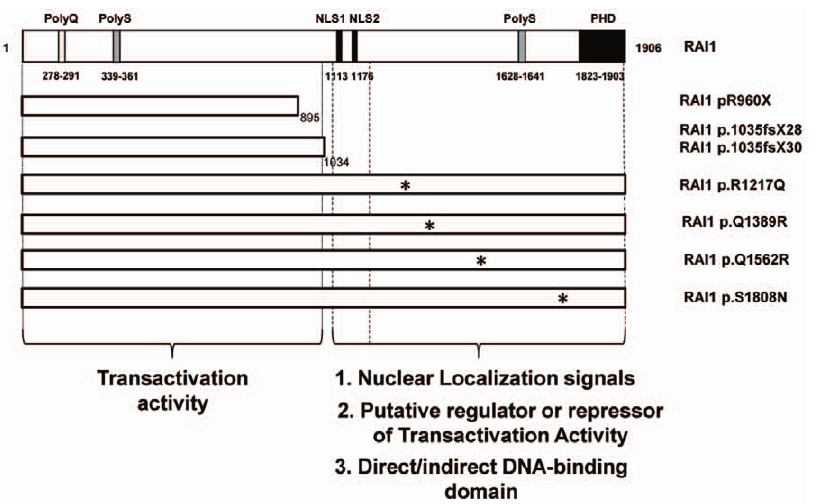
Figure 5. Schematic representation of RAI1 functional domains. The schematic representation of all the mutants analyzed in this study is shown. An asterisk represents the missense mutations. The N and C-terminal halves of the protein are depicted with the description of their functional role.